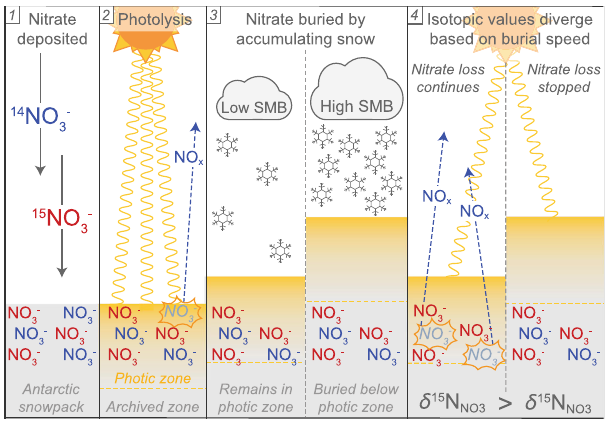
Fig. 1 Schematic diagram of the NO 3 − photolytic process in Antarctica. After NO 3 − containing either 14 N (blue) or 15 N (red) is deposited on the Antarctic snowpack surface (1), sunlight in the photic zone can trigger photolysis of NO 3 − that favors NO 3 − with a 14 N atom, which leaves the residual NO 3 − enriched in 15 N (2). Because sites with lower surface mass balance will accumulate less snow over a given period of time than high surface mass balance sites (3), the NO 3 − at lower surface mass balance sites will remain in the photic zone longer, experience more photolytic mass loss before burial in the archived zone, and have higher δ 15 N NO3arc values